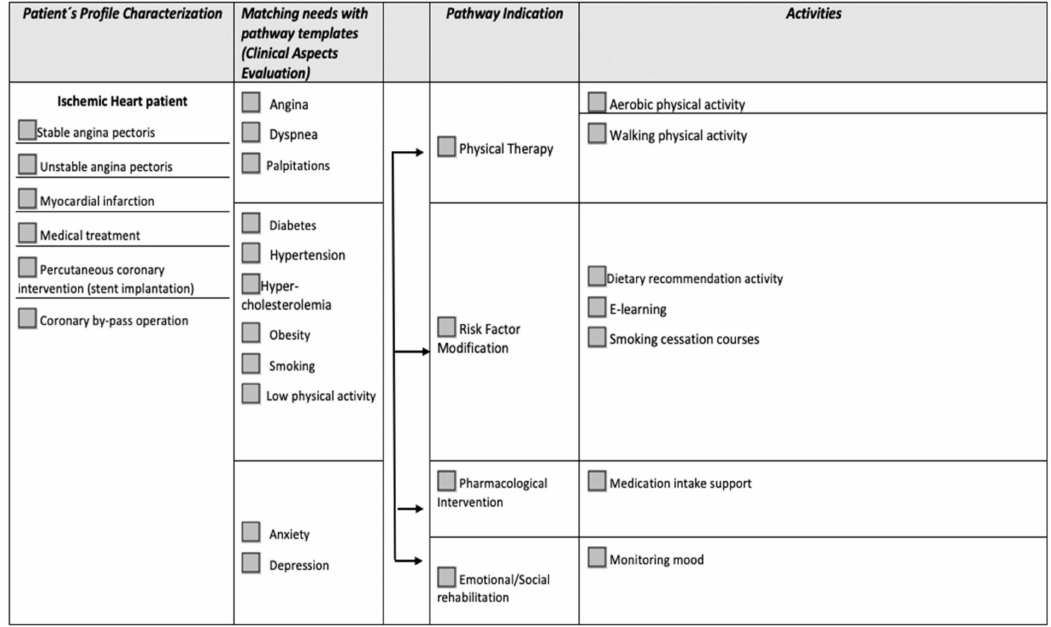
Figure 2. Available pathways for ischemic heart disease